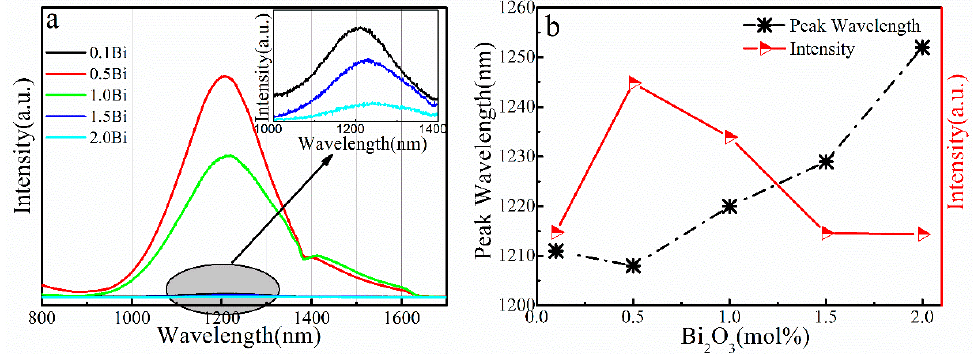
Figure 2. ( a ) PL spectra of glass samples excited by a 480 nm LD. ( b ) Dependencies of emission intensity and peak wavelength on Bi 2 O 3 concentration. The (59.5 − x) SiO 2 -10Al 2 O 3 -30CaO-0.5Bi 2 O 3 -xSnO 2 (x = 0.2, 0.4, 0.6, 0.8, 1.0) glass sam-